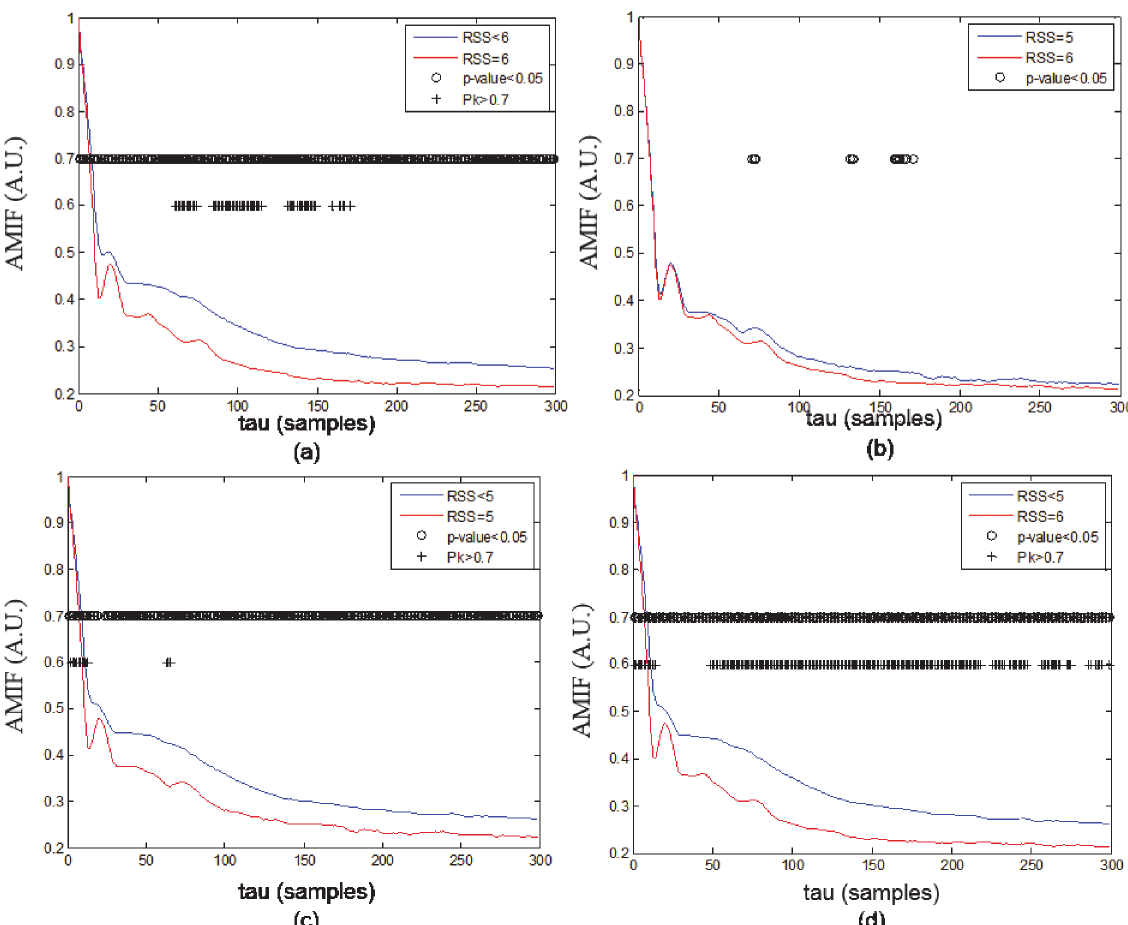
Fig 2. Auto-Mutual Information Function (AMIF). Averaged AMIF functions in θ band q = 50 of all windows of (a) RSS < 6 and RSS = 6, (b) RSS = 5 and RSS = 6, (c) RSS < 5 and RSS = 5, (d) RSS < 5 and RSS = 6. The p-values were corrected using Bonferroni equation.